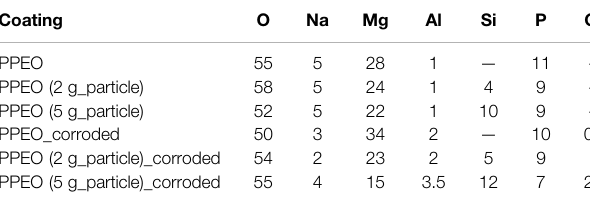
TABLE 1 | Surface composition (at. %) of the coatings before and after corrosion test.